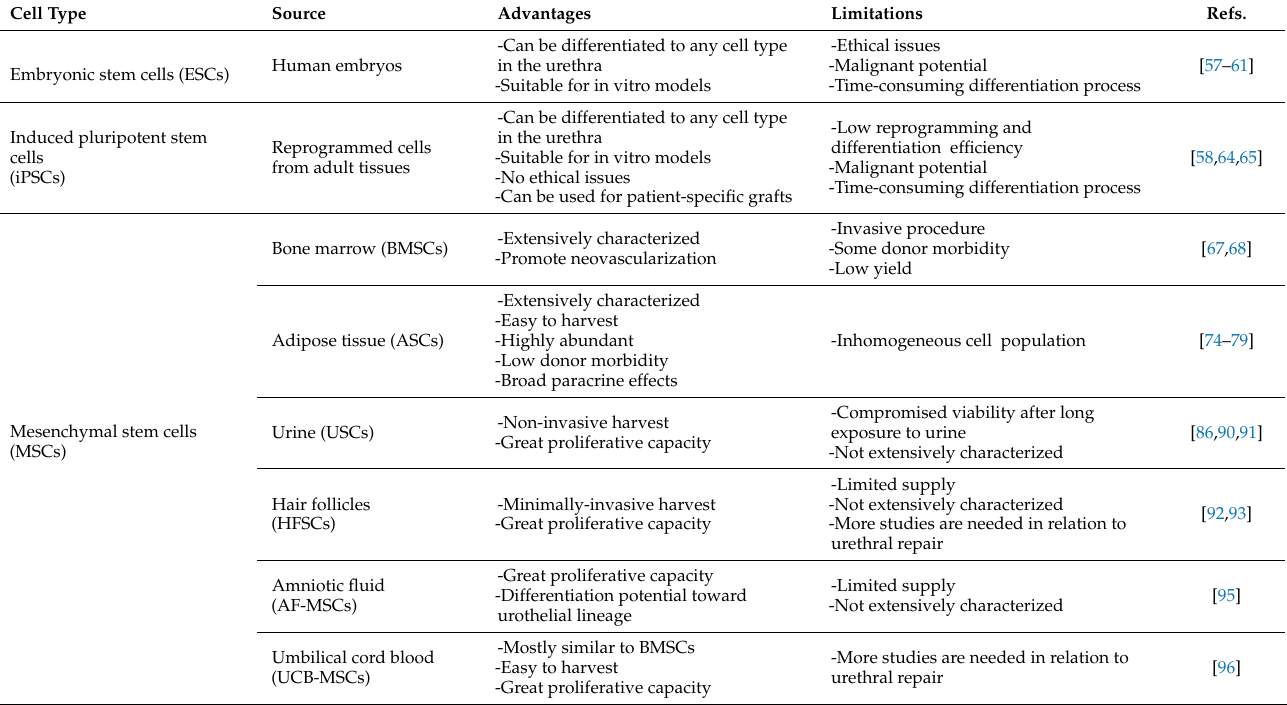
Table 2. Summary of main properties of stem cells used in urethral tissue